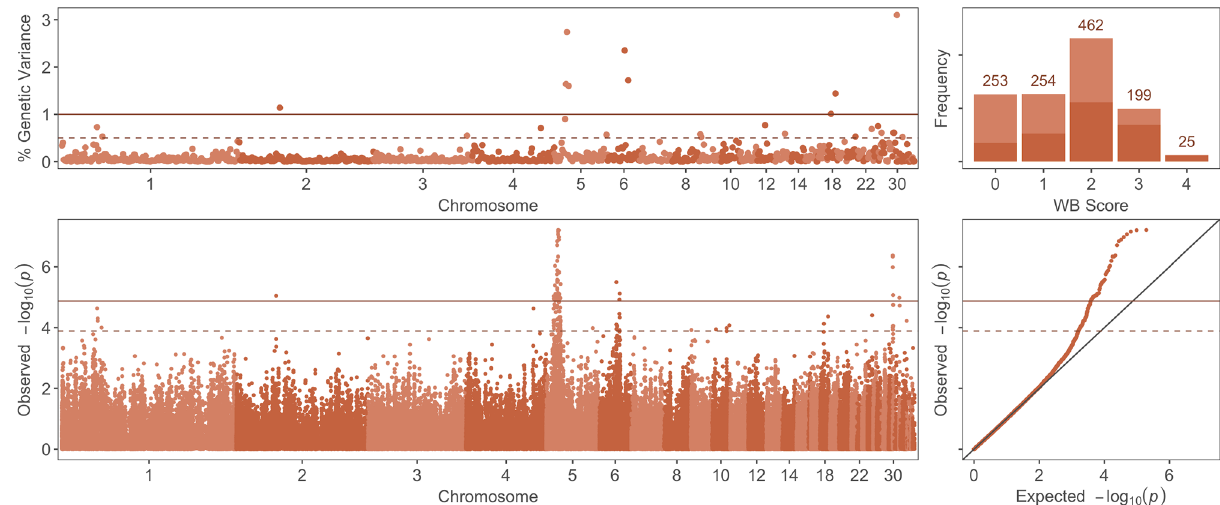
Figure 1. Genome-wide association results for wooden breast (WB) score using multi-marker (BayesB) and single-SNP (mixed linear model) analyses. (Top Left) Percentage of genetic variance explained by 1-Mb regions across the genome for WB score. (Top Right) Distribution of WB scores across progeny used in genome-wide association analyses; dark red = male, light red = female. (Bottom Left) Manhattan plot of single-SNP results showing the − log10( p -value) of SNPs ordered by chromosome and position. (Bottom Right) Quantile–quantile plot of p -values from single-SNP results of WB score. Solid and dashed lines indicate significant and suggestive thresholds, respectively, for each